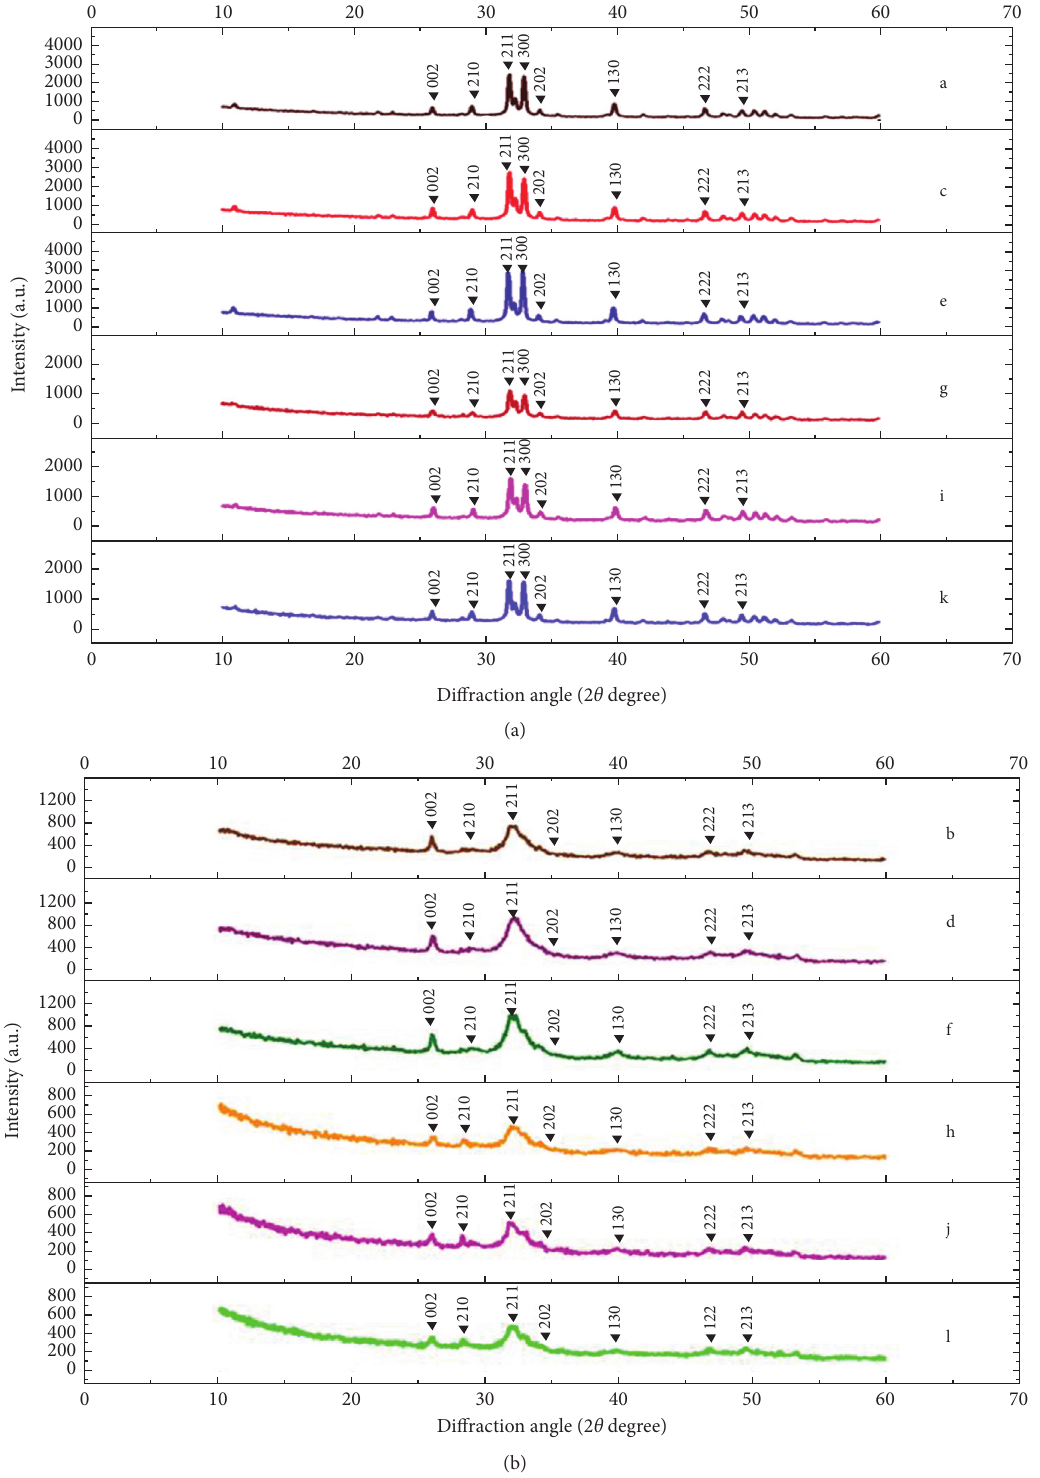
Figure 5: The X-ray diffraction (XRD) pattern of enamel (a) and cementum (b) before material application (a, b), after surface applied with NHA (c, d), and Clinpro (e, f) and after demineralization to a nontreated surface (g, h), NHA treated surface (i, j), and Clinpro treated surface (k,